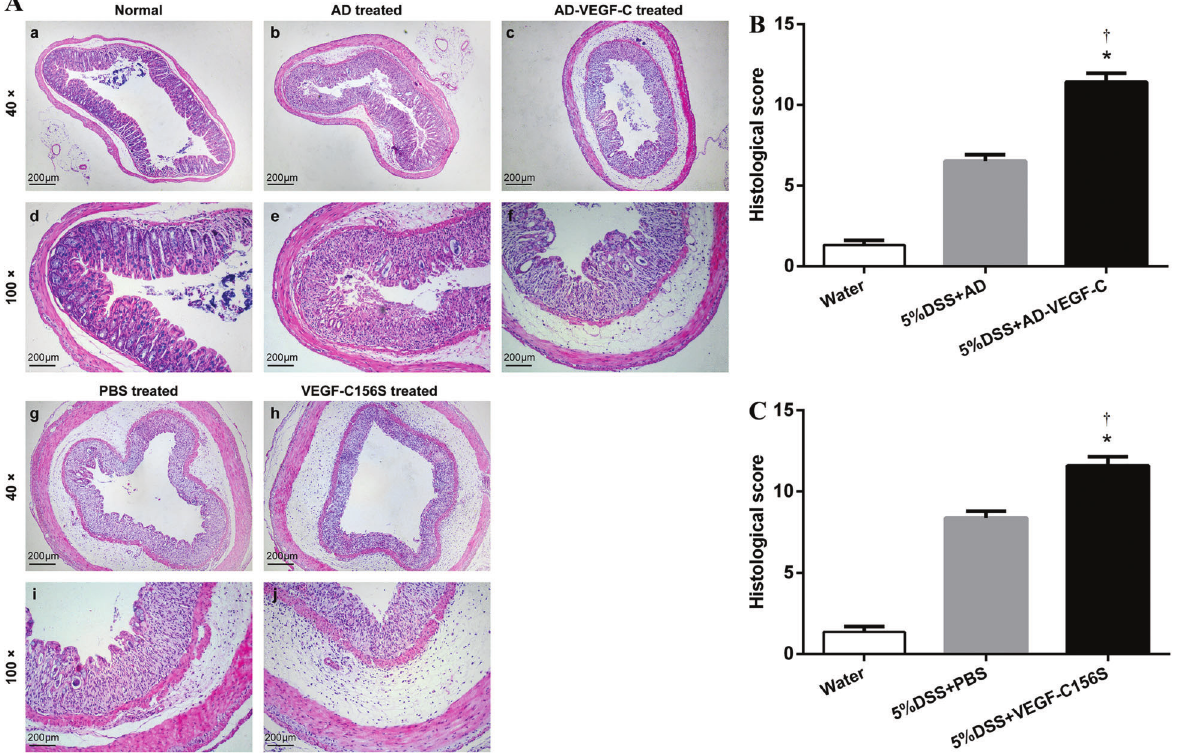
Figure 2. A , Assessment of histological scores in the different groups. Histology of normal tissue is shown in panels a and d , acute colitis was induced with DSS in DSS-treated mice (panels b and e ); in AD-VEGF-C-treated mice (panels c and f ); in PBS-treated mice (panels g and i ); and in VEGF-C156S-treated mice (panels h and j ). DSS-treated mice showed signi fi cantly greater histological damage (cellular in fi ltration, goblet cell depletion, damage to crypt architecture and submucosal edema) ( A: b , e , g , i ) compared to normal mice. VEGF-C- treated mice exposed to DSS showed signi fi cantly higher histological scores with more severe histological damage compared to control DSS-treated mice, both in the AD-VEGF-C ( B , P o 0.001) and AD-VEGF-C156S groups ( C , P o 0.001). Data are reported as means ± SD. *P o 0.05 compared to DSS- or PBS-treated mice (n=5/per group). w P o 0.05 compared to water-treated mice (n=5/group). Statistical analysis was performed by ANOVA and Bonferroni ’ s post-hoc test. AD: adenovirus; PBS: phosphate-buffered saline; AD-VEGF-C: adenovirus vascular endothelial growth factor-C; DSS: dextran sodium